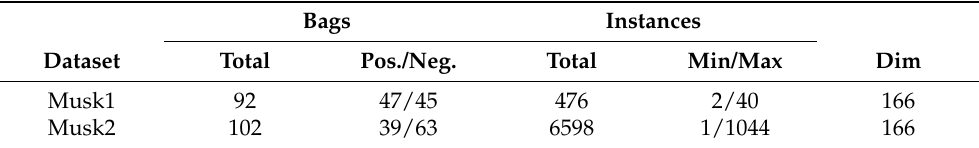
Table 1. Musk datasets and the average number of instances per bag(Inst/Bag) for each dataset. Bags